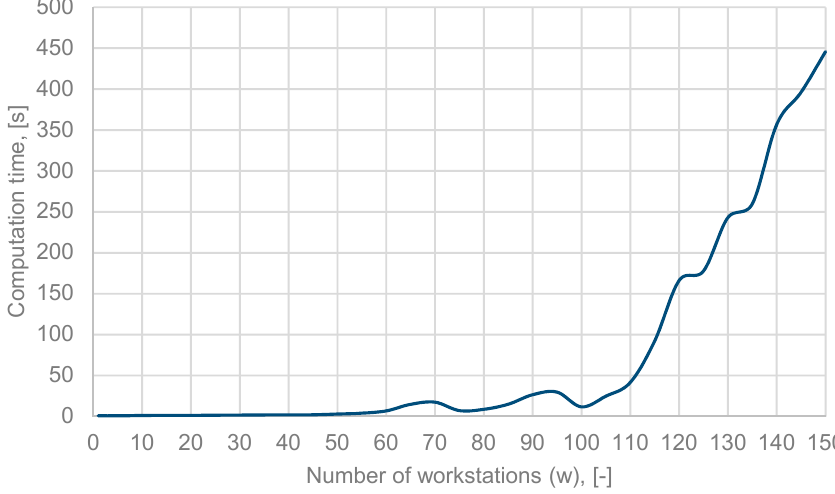
Figure 3. Model computation time as a function of the number of workstations.